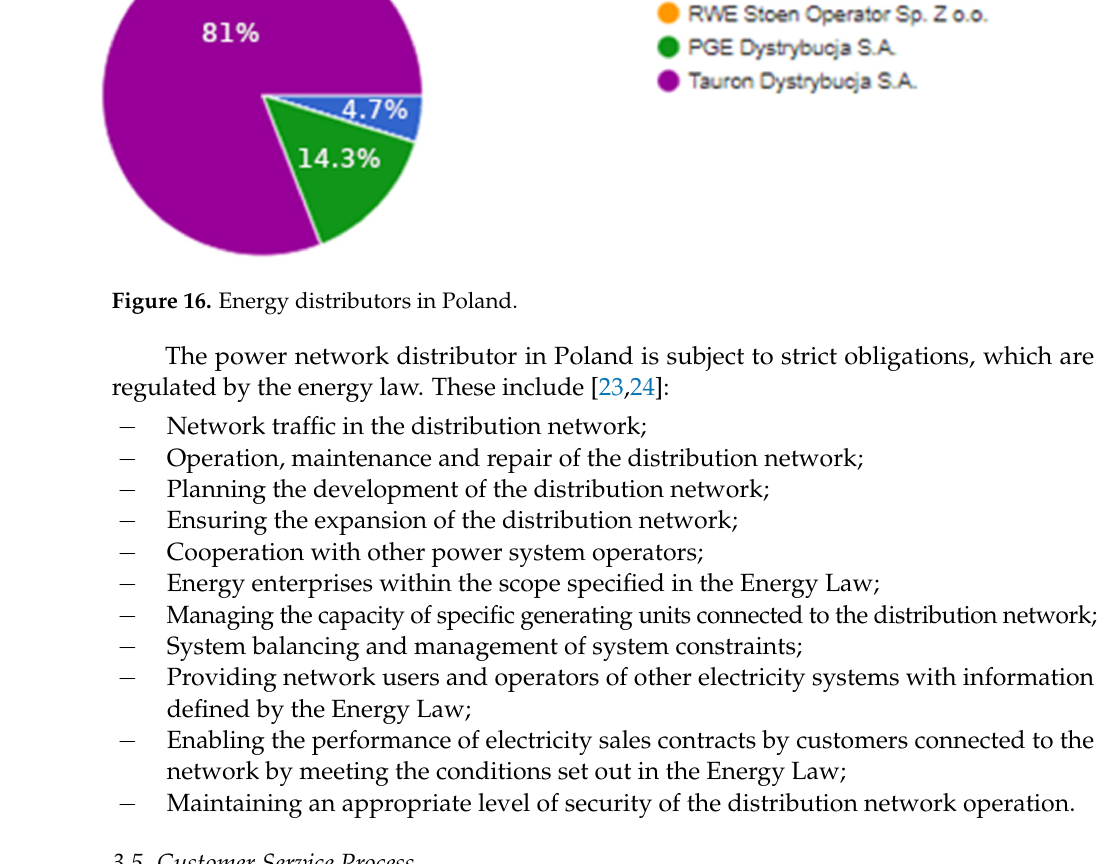
Figure 17. Opinion about the service provider.